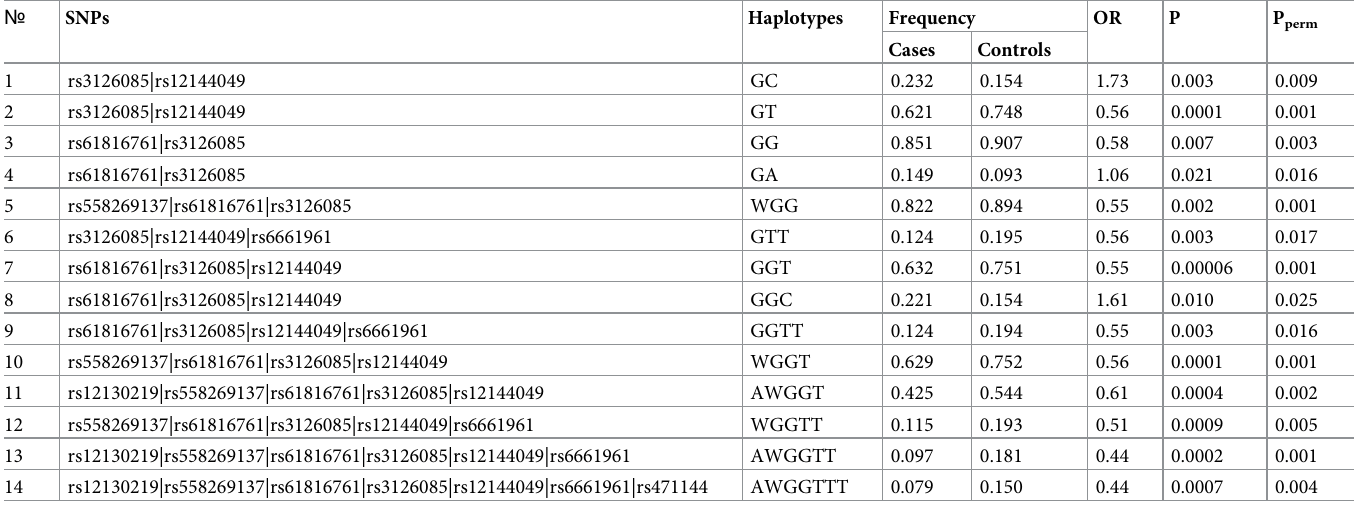
Table 3. Significant associations of the FLG gene haplotypes with AD in females (P perm � 0.025). №